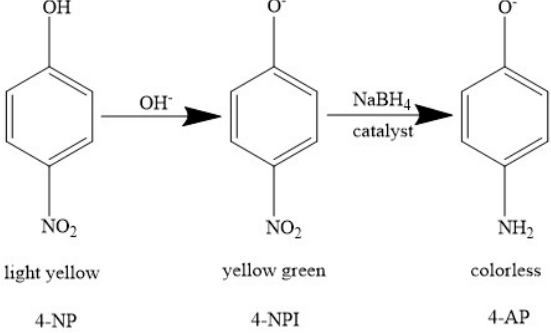
Figure 2. Conversion from 4-NP to 4-AP.